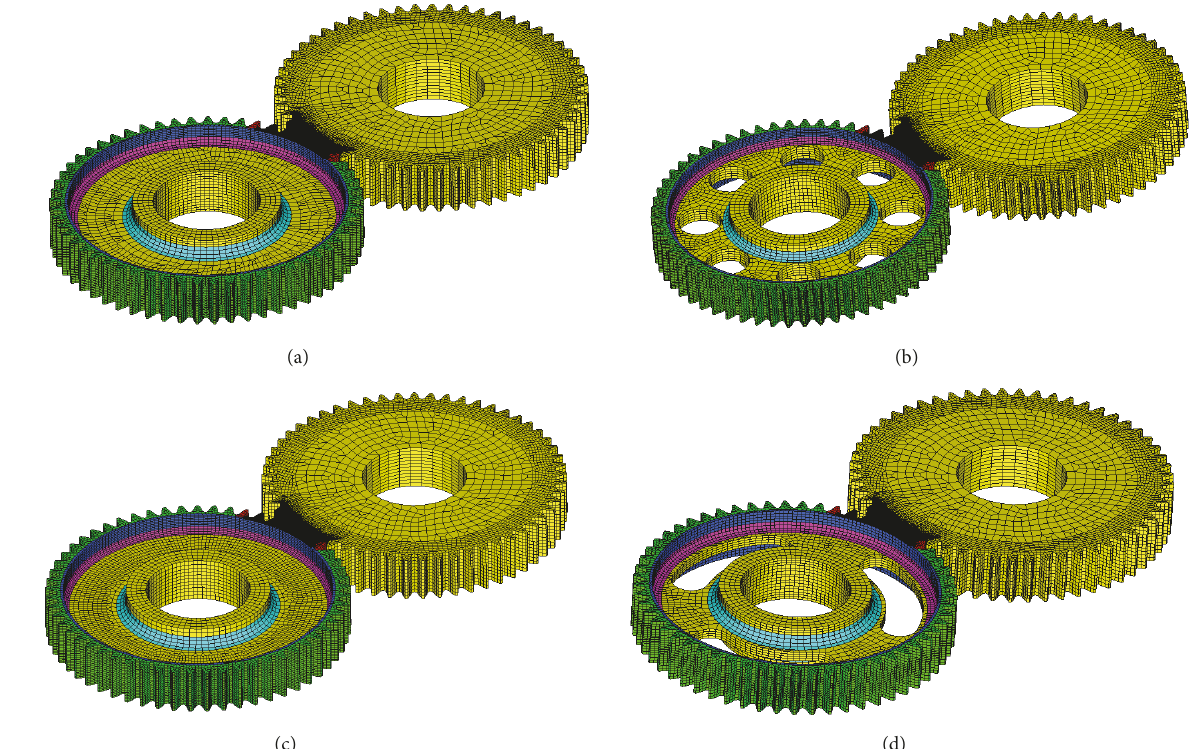
Figure 1: FE models of the four gear pairs analysed: (a) and (c) have an axisymmetric design for the lightweight gear, while 8 holes and 3 slots enable mass reduction in (b) and (d), respectively, with different degrees of discrete rotational symmetry. Gears (a) and (b) are designed to have the same total mass; the absence/presence of the holes cause different effect on blank stiffness; the same holds for gears (c) and